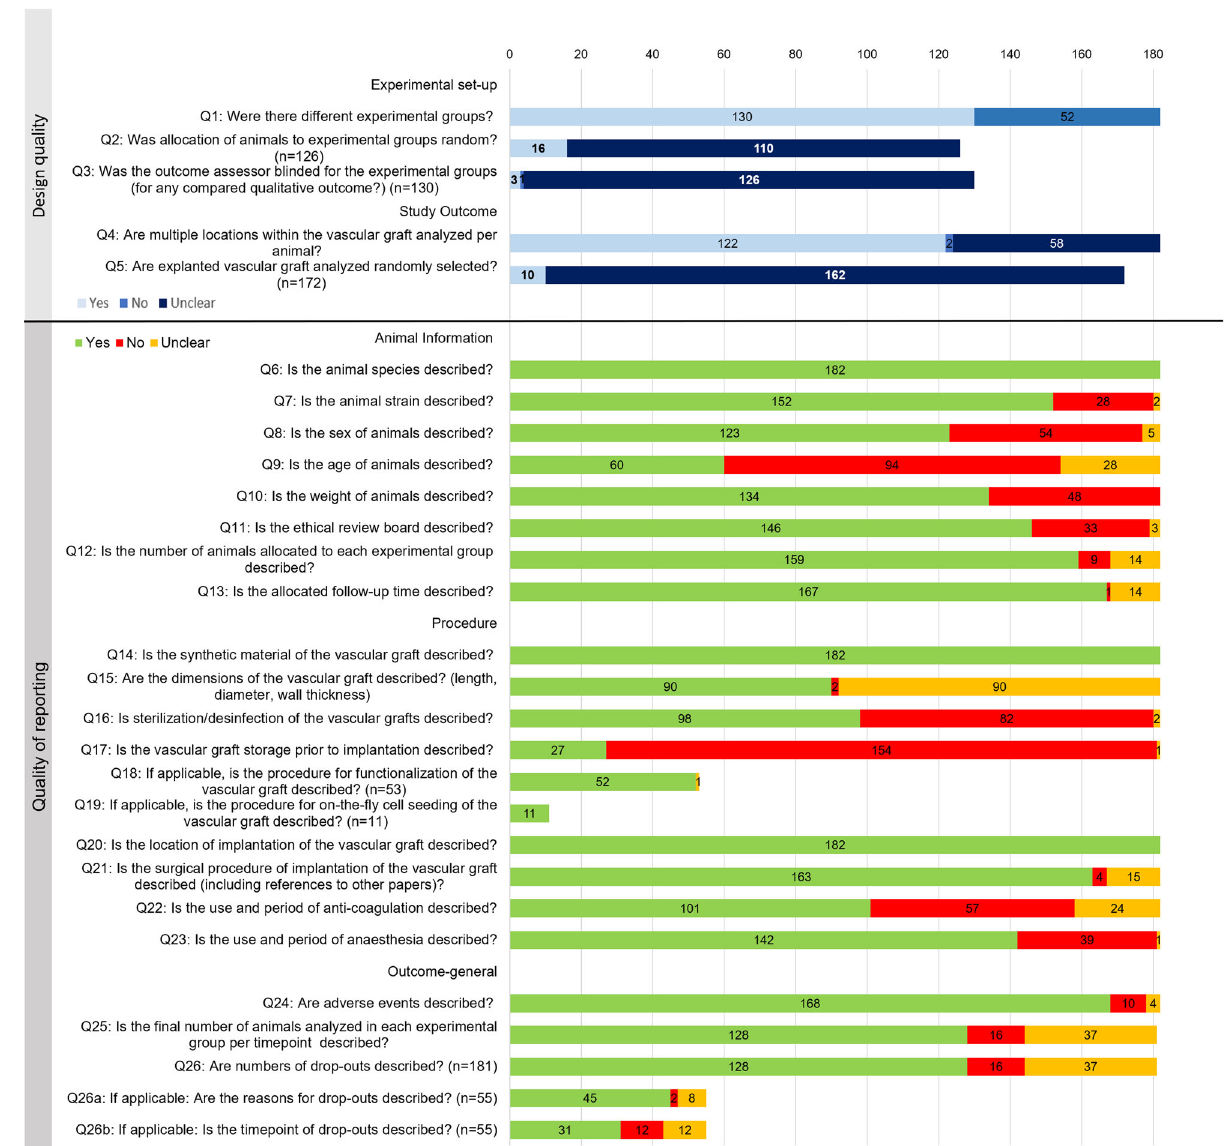
the de fi nition of separate answers per